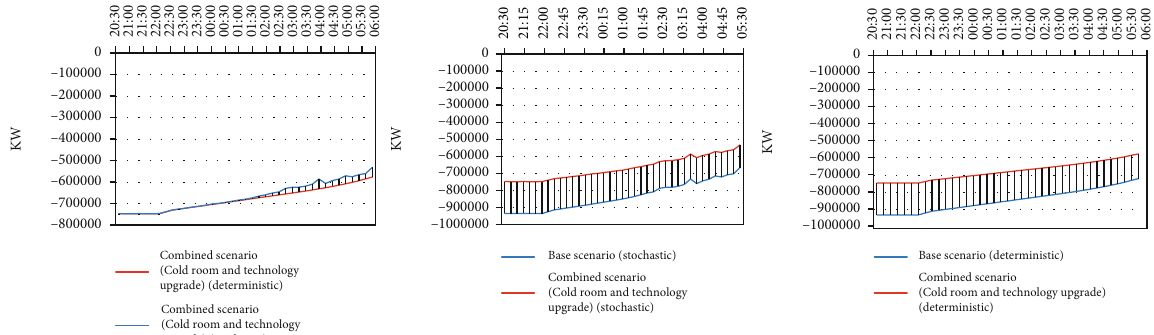
Figure 32: Di ff erent modes in the combined scenario (cold room and technology upgrade) (night).